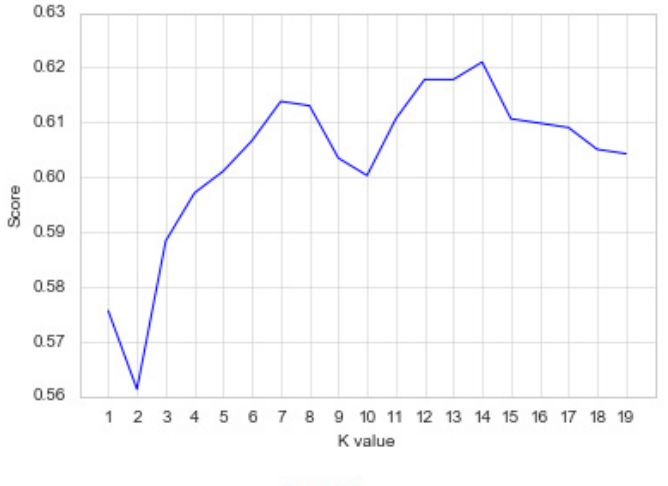
Figure 12. The graphic that represents the best number of neighbors to choose for k-nearest neighbor (KNN), where k represents the number of neighbors.